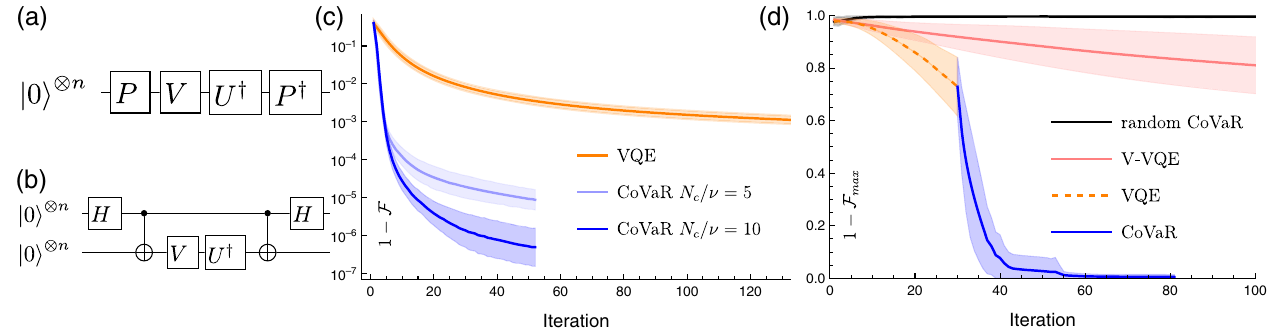
FIG. 7. Demonstration of CoVaR in fixed input state recompilation for a ten-qubit and two-layer ( ν ¼ 88 ) Ansatz . The circuit in (a) is used with V and U being the same Ansatz but with V having solution parameters θ ⋆ that are randomly chosen as j θ ⋆ j ≤ 2 π but remain k fixed over 20 runs. We rediscover these hidden parameters using the Ansatz U ð θ Þ , where θ ¼ θ ⋆ þ Δ θ . All curves show mean and 10 5 ). (b) shows the circuit for the recompilation standard deviation of infidelities over 20 runs, and simulations include shot noise ( N s ¼ = ν ¼ 5 , 10 compared with gradient descent (orange). Infidelity 1 − F of a full unitary. (c) Performance of CoVaR (blue lines) using N c ≤ 0 . 3 resulting in an from the ground state is plotted as we initialize close to the solution via small random parameter perturbations j Δ θ k j ≤ 2 π , showing initial fidelity 1 − F ¼ 41 (cid:4) 8% . (d) Performance when initialized completely randomly in parameter space via j Δ θ k j the infidelity 1 − F to the nearest computational basis state. Black shows progress for CoVaR and red for variance-VQE — when both max are initialized randomly, both fail to make significant progress, regardless of choice of N . Additionally shown is the use of a short c = ν ¼ 20 ), which reaches a final infidelity of period of gradient descent to “ initialize ” (orange, dashed line) and then CoVaR (blue, N c 0.5% on average (the blue curve includes only the 16 = 20 runs which are able to